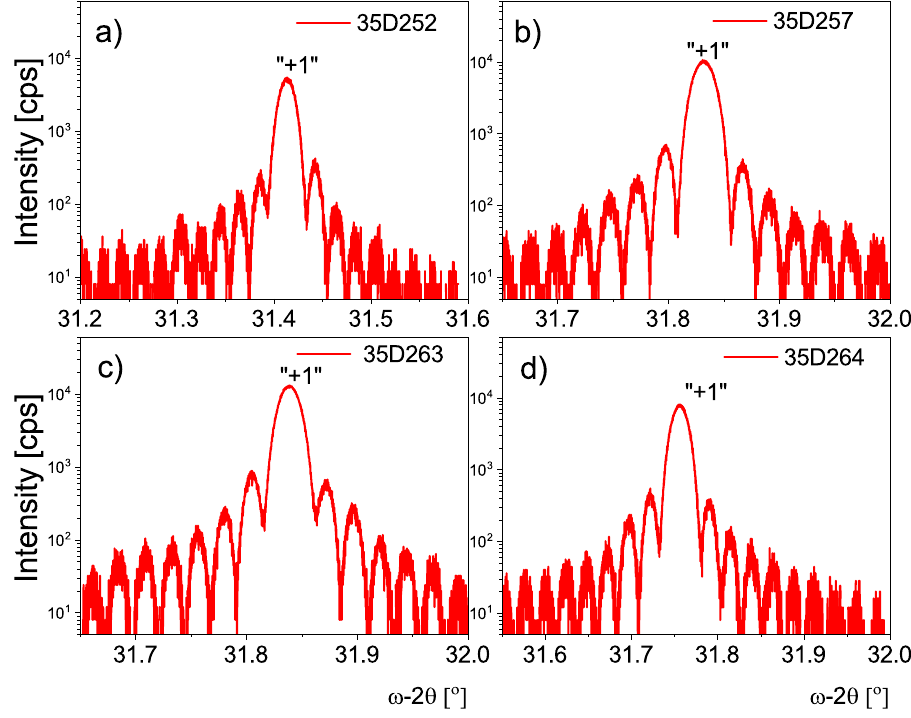
Figure 3. Magnified pictures the first satellite of the HRXRD measurements for all investigated samples: ( a ) 35D252, ( b ) 35D257, ( c ) 35D263, ( d ) 35D264 with the Pendeläsung